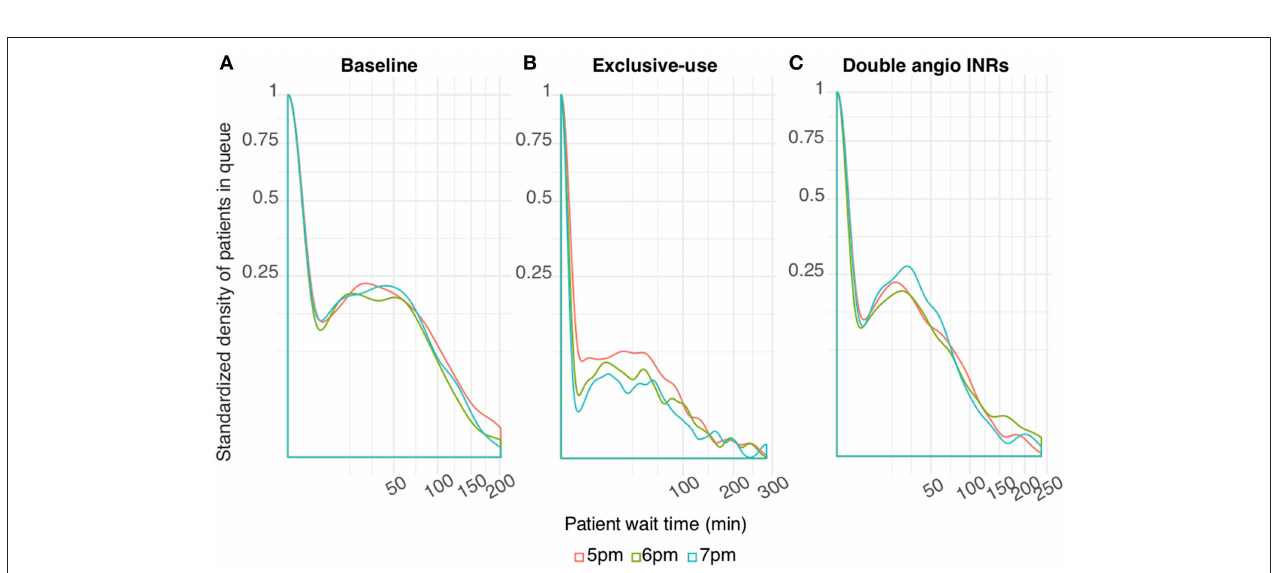
FIGURE 3 | The effect of increasing working hours on ECR patient wait time at angioINR (A) . Baseline scenario (B) . Exclusive-use scenario (C) . Two angioINRs scenario. Standardized density of patients in queue: the probability density of patients who are waiting standardized to patients who are not waiting.